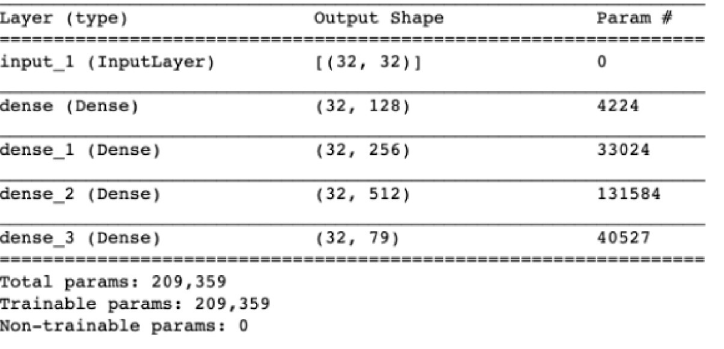
Fig 2. Generator network description.